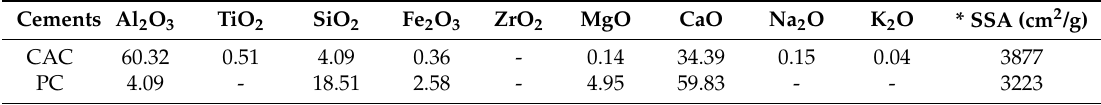
Table 3. Chemical analysis of cements (Oxide wt %).